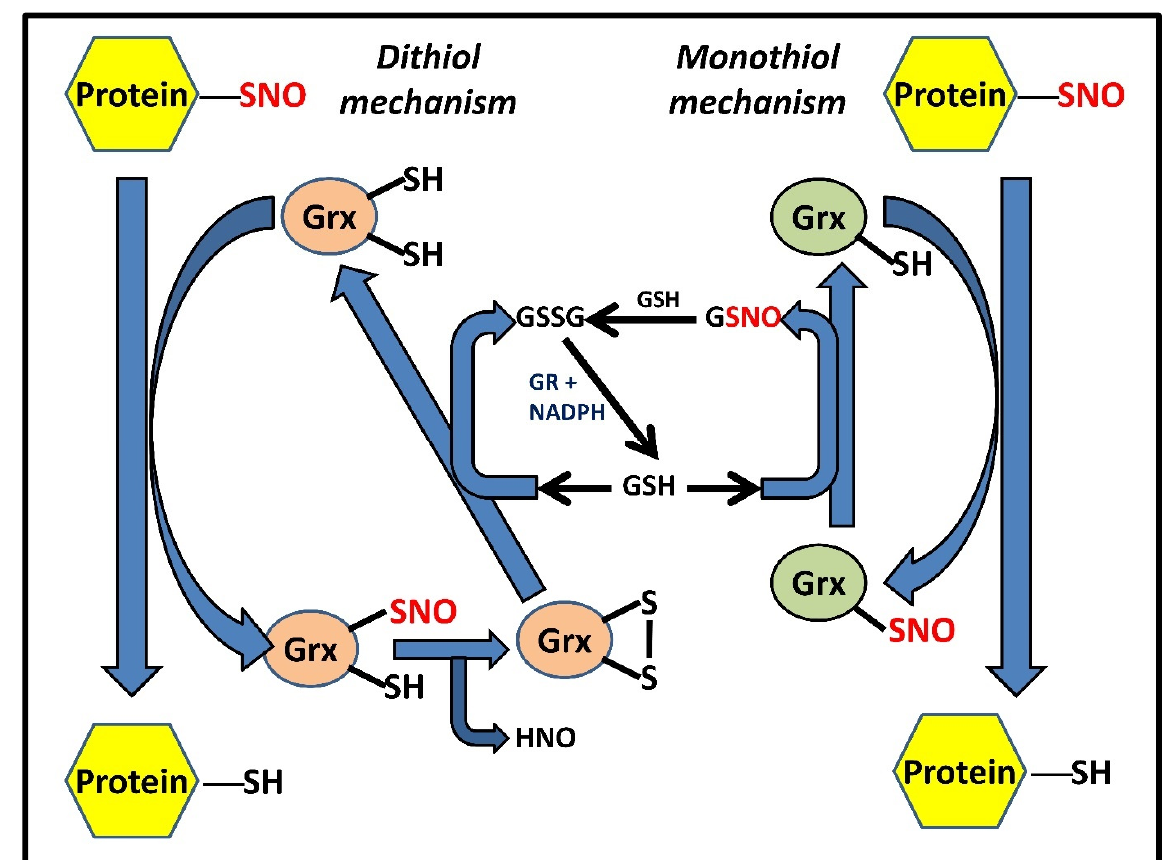
Figure 3. Grx-catalyzed denitrosylation of PSNOs via dithiol and monothiol mechanisms. Two distinct yet functionally similar Grx-dependent mechanisms have been proposed that can suffice for protein denitrosylation [13]; (a) the dithiol mechanism wherein Grx shuttles between three competent oxidant states, namely the reduced dithiol Grx-(SH) 2 , an intermediate Grx-(SNO)(SH), and the oxidized disulfide Grx-S 2 form, (b) the monothiol mechanism involving Grx with only an active N- terminal cysteine residue Grx-(SH) and the Grx-SNO form. While the figure shows GSH dependency in both systems for continuous enzymatic turnover, it also highlights additional disparities between the mechanisms, such as the coupling of GSH with monothiol Grx for exhibiting denitrosylase activity, unlike its dithiol form.